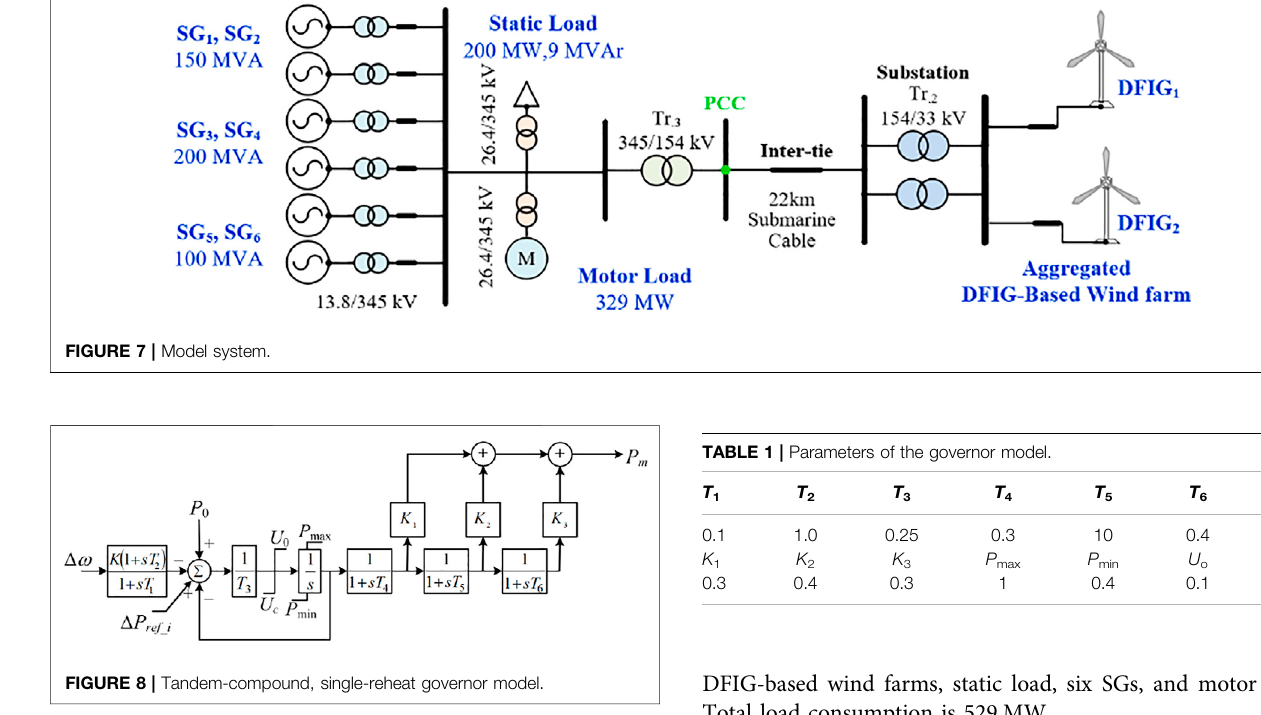
Table 1 . IEEE X1 is used for voltage control.